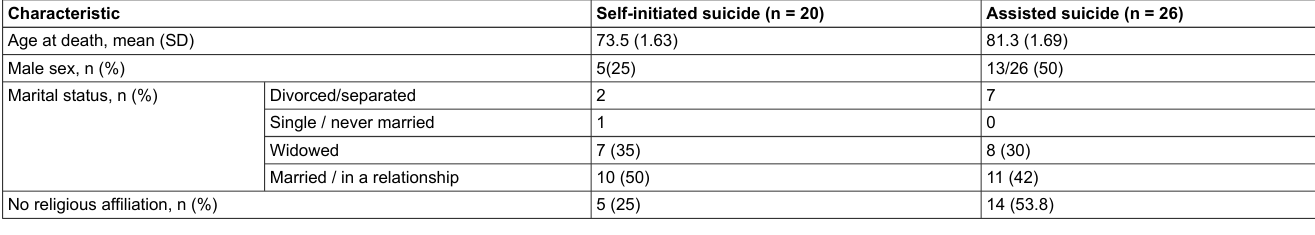
Table 1: Sociodemographic characteristics and declared religious affiliation in elderly who did attempt(s) before dying by assisted or self-initiated suicide, Geneva, Switzerland, 2010–2019.